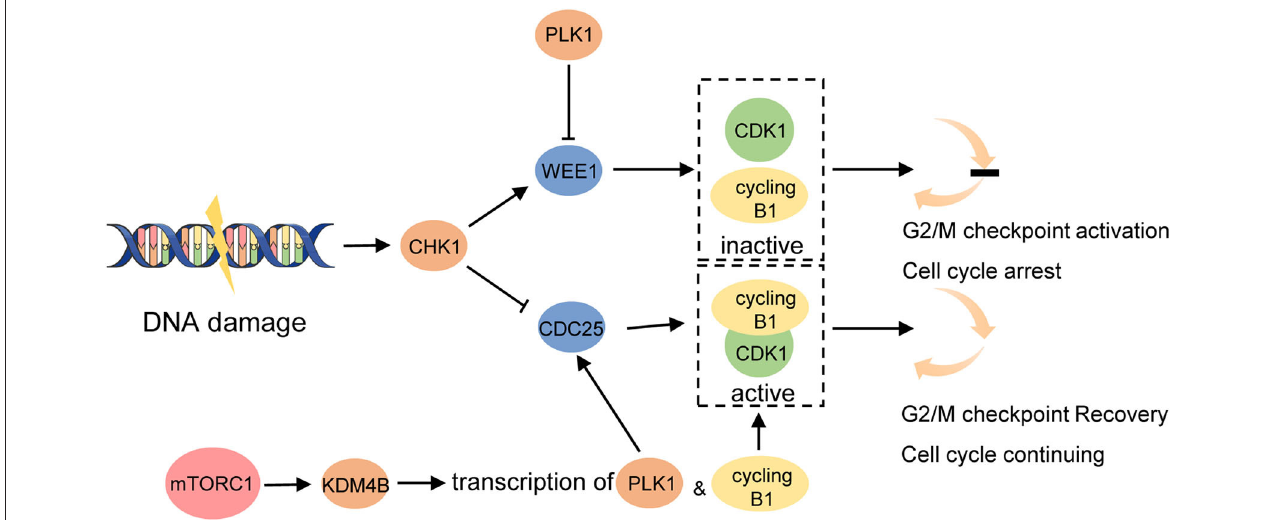
FIGURE 4 | mTORC1 promotes G2/M checkpoint recovery triggered by DNA damage. DNA damage activates CHK1. It then activates WEE1 which maintains cyclin B1 complexed with CDK1 inactivated and prevents cell cycle from entering mitosis. CHK1 inhibits CDC25 at the same time which activates CDK1/cyclin B1 complex and promotes G2/M checkpoint recovery. Hyperactivated mTORC1 increases the function of KDM4B which increases the transcription of cyclin B1 and PLK1. PLK1 activates CDC25 and inhibits WEE1 to promote the cell cycle to